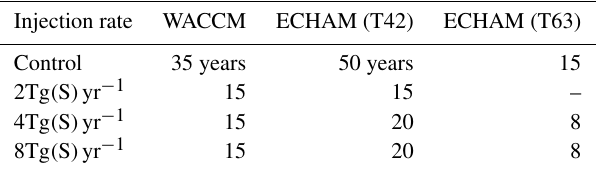
Table 1. Summary of simulations carried out with WACCM and ECHAM. Given is the number of years used for time averaging in this study. The results are not sensitive to the number of years used to calculate time